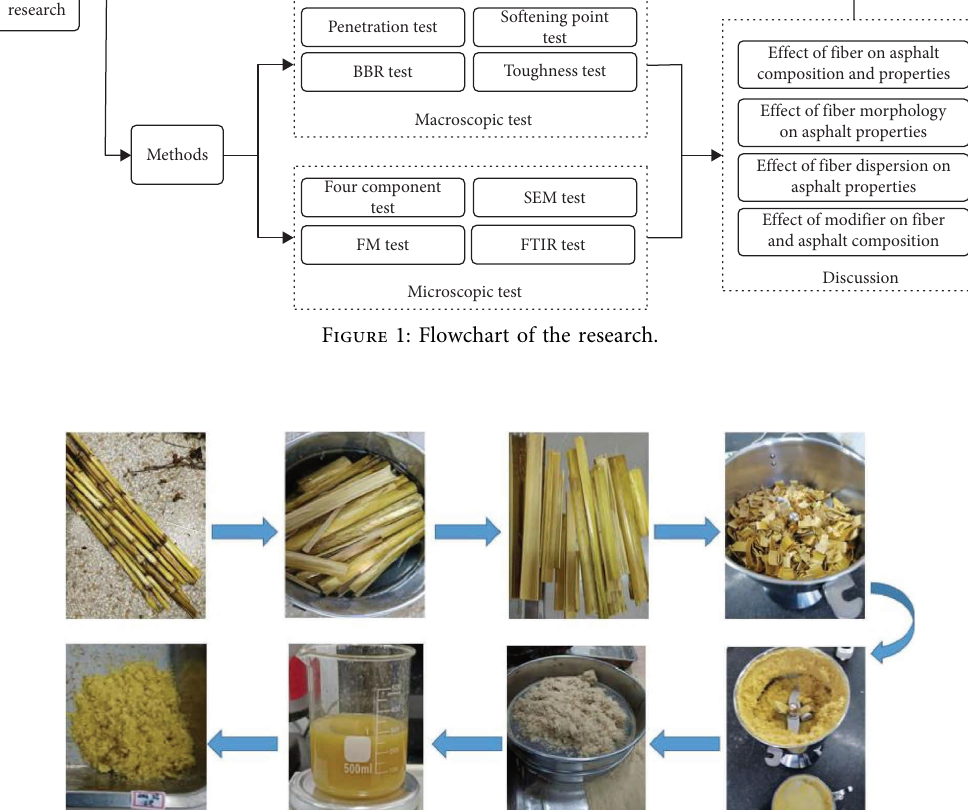
Figure 2: Production and modifcation process of corn straw fber.